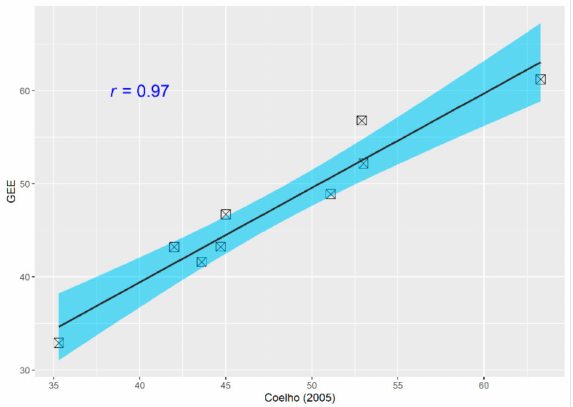
Figure 11. Spearman correlation coefficient between coastline retreat along the profiles of GEE model and [57] study (R 2 = 0.93, r =